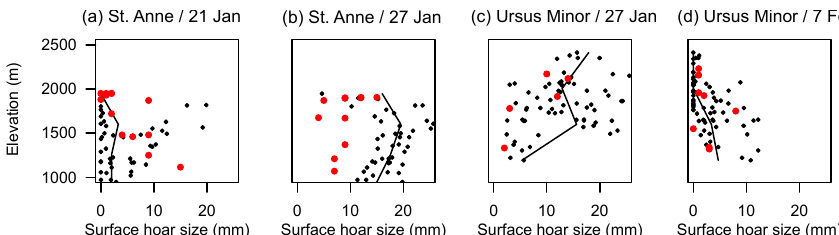
Figure 8. Surface hoar sizes observed over different elevations on Mont-Sainte-Anne and Ursus Minor Mountain (red dots). Black dots show the sizes modelled at grid points within a 10km radius of the mountains, and the moving average with a black line.